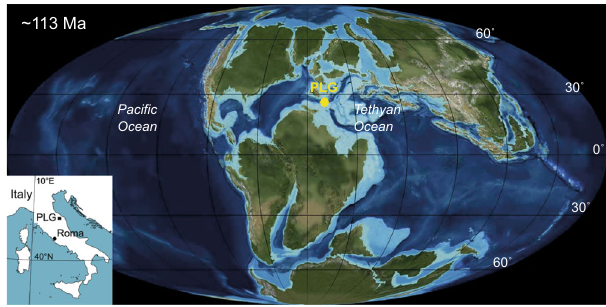
Fig. 1 Paleogeographic reconstruction at 113 Ma. Location of the Poggio le Guaine (PLG) core in the Tethyan realm at 113 Ma